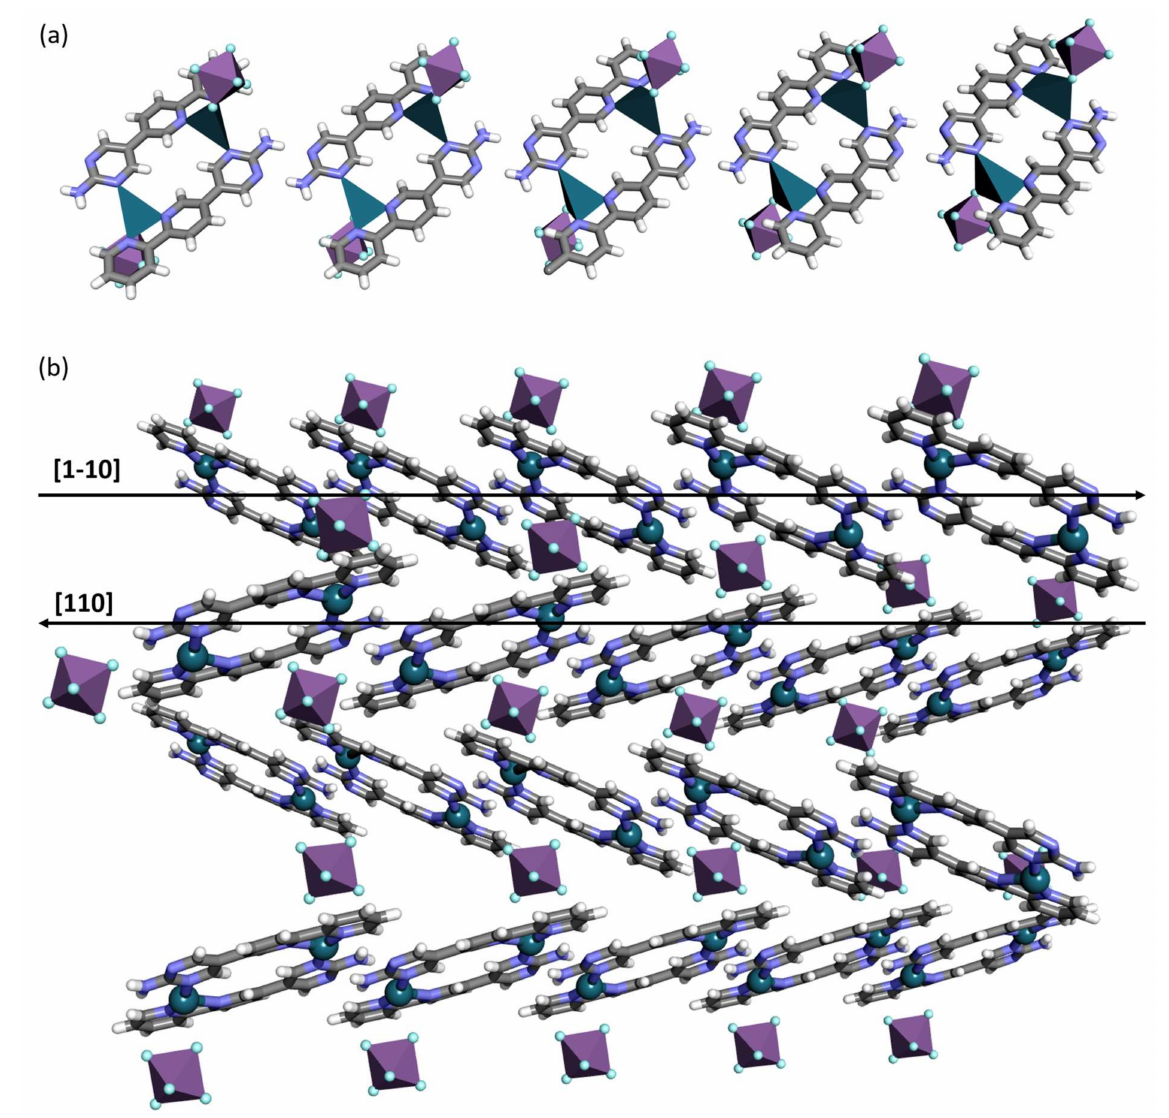
Table 2. Un-like the structure of mer-[Fe II L 3 ](BF 4 ) 2 · 9H 2 O, that of [Ag 2 L 2 ](SbF 6 ) 2 shows no evidence of significant apparent void space (Figure S6).